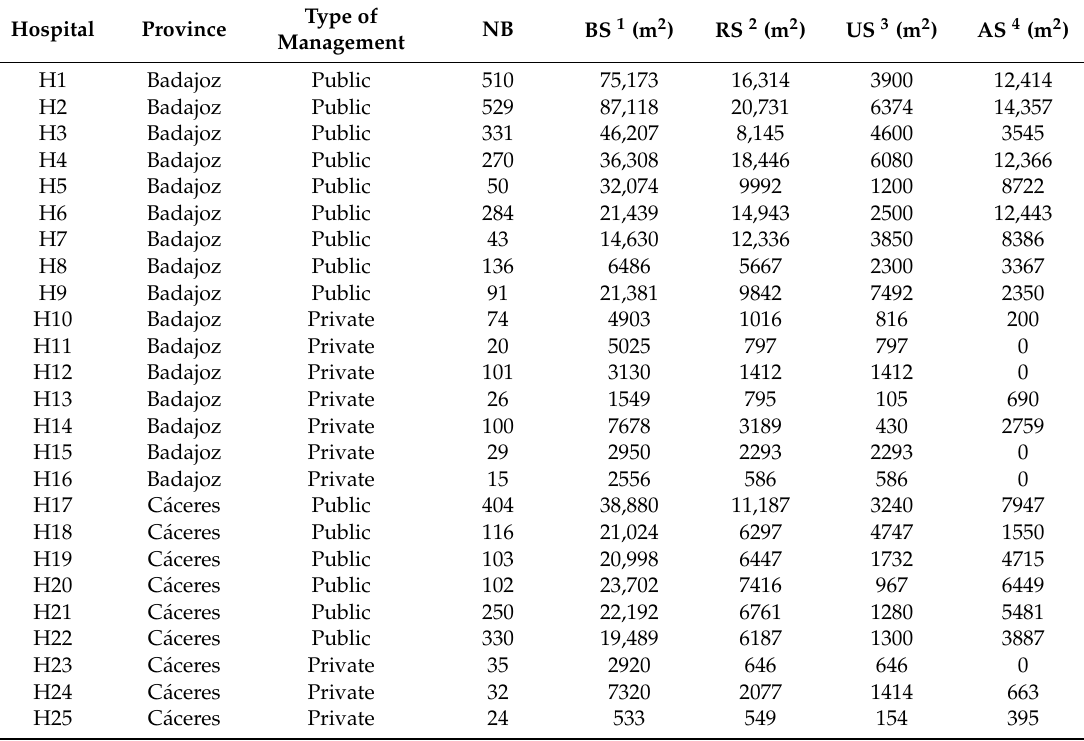
Table 1. Functional characteristics of the hospitals under